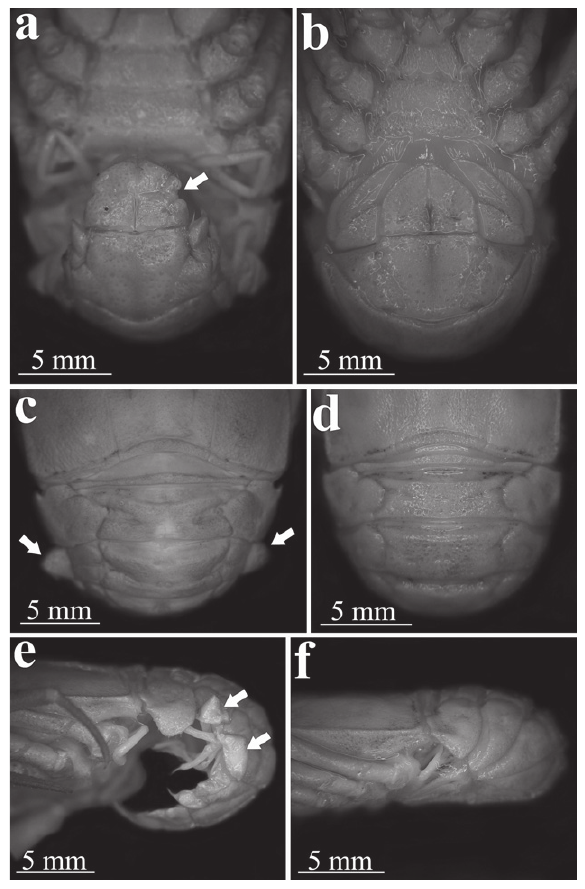
Fig. 2 - Aegla marginata on ventral, dorsal and lateral view. a, c, e) specimen found with carapace abnormalities; b, d, f) normal specimen found on same place. White arrows indicates the abnormalities on